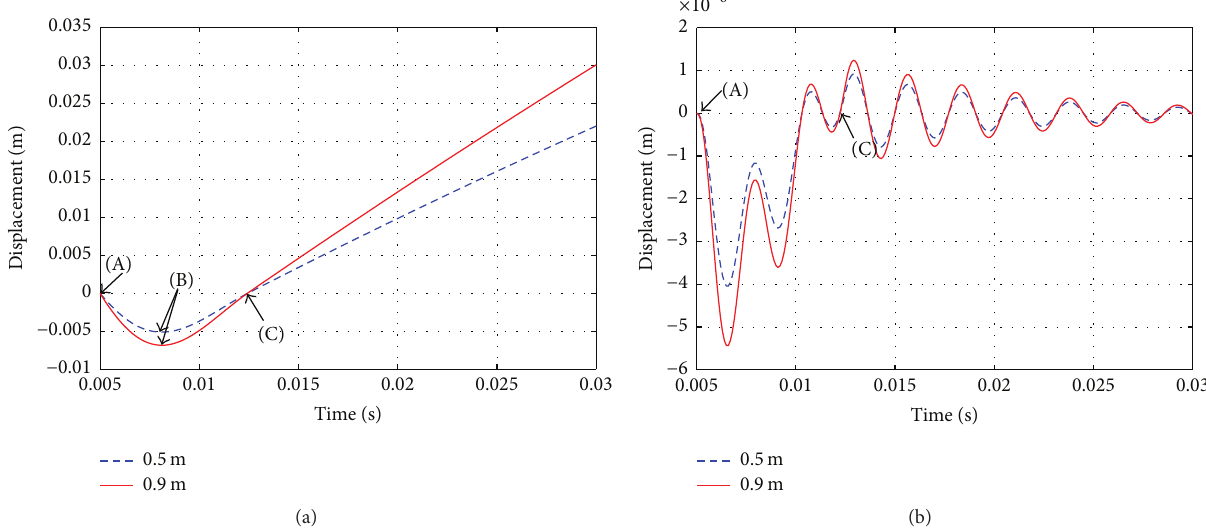
Figure 8: Simulated displacement of the child (a) and force plate (b) DoFs during impact for 0.5 m (T02) and 0.9m (T04) fall